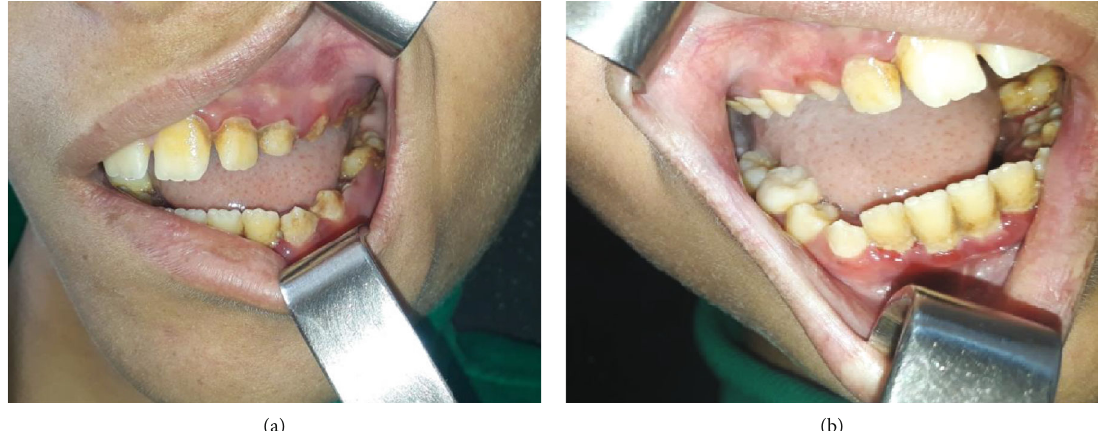
Figure 3: Oral examination showing poor oral hygiene and discolored